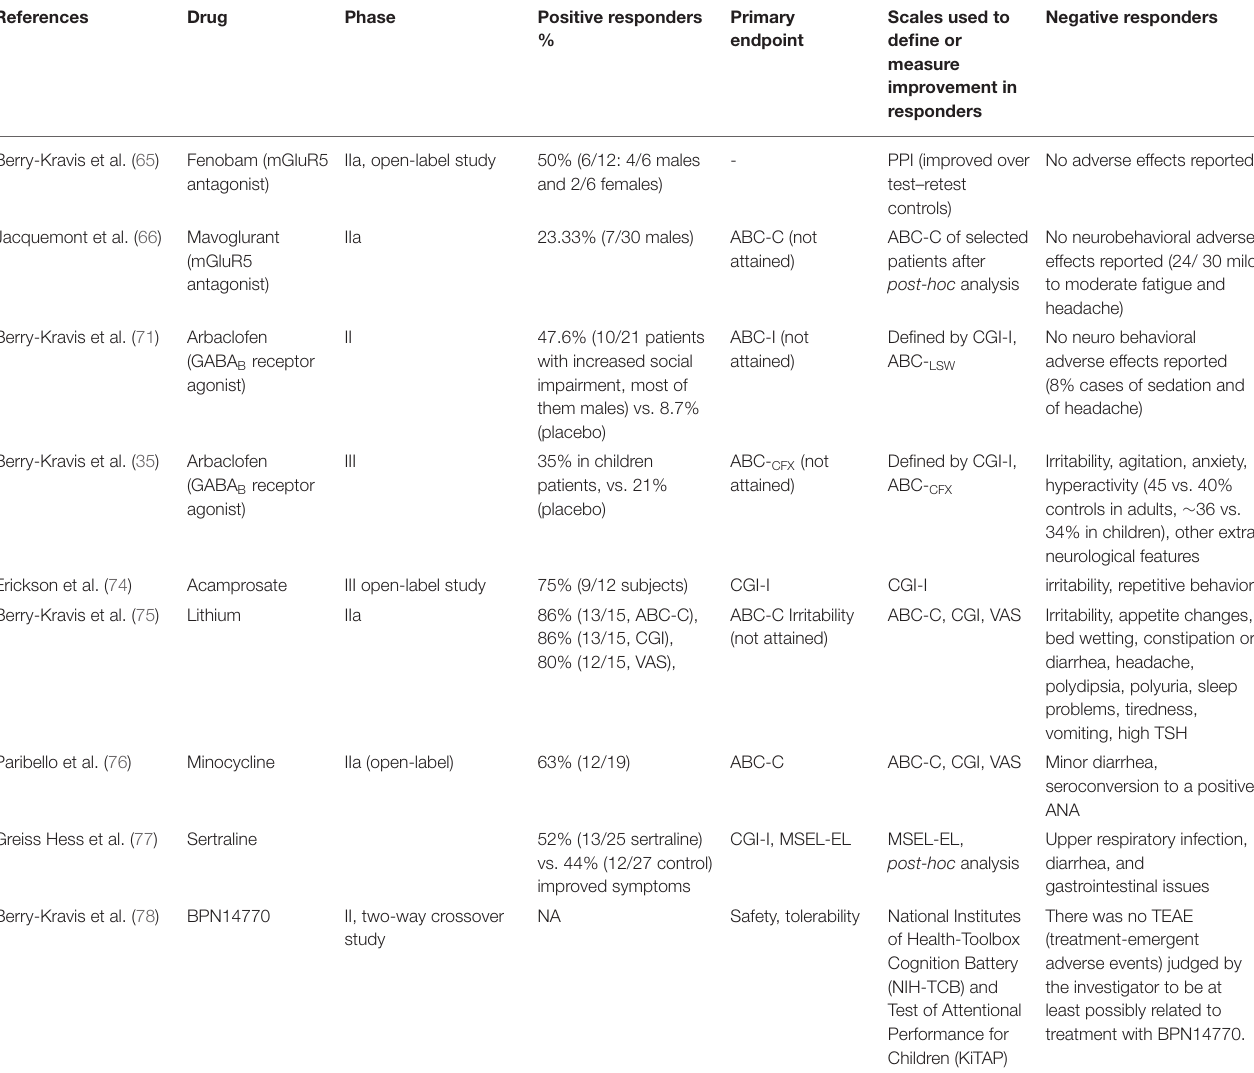
TABLE 4 | FXS clinical trials showing positive responder